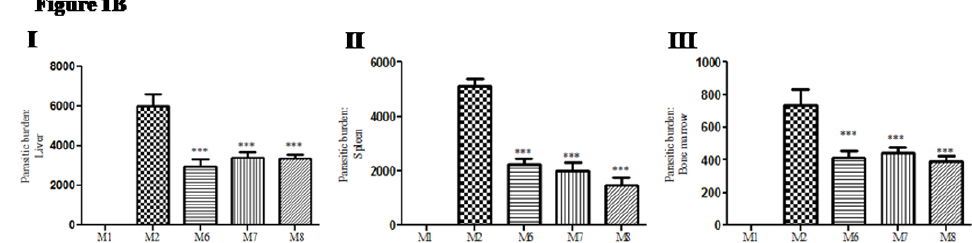
Fig 1B. Therapeutic use of recombinant cytokine(s) inhibit parasitic growth in visceral organs of Leishmania donovani infected mice: After sacrifice of mice,tissue specimens from visceral organs were used for estimation of parasitic load. Crushed cells were spread on the slide and after methanol fixation, stained with Giemsa stain and then observed under the microscope (10 X 100). (I) Parasitic load in liver (II) Parasitic load in spleen (III)